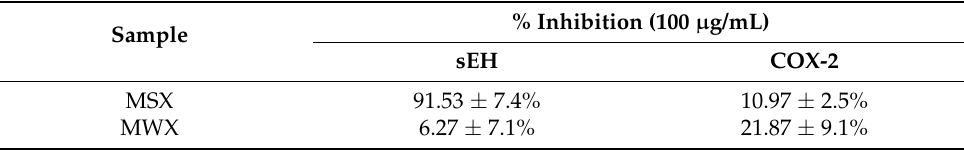
Table 3. Anti-inflammatory effects of maple food extracts MSX and MWX in the inhibition assays against soluble epoxide hydrolase (sEH) and cyclooxygenase-2 (COX-2). All samples were tested in triplicate and data are presented as the mean ±